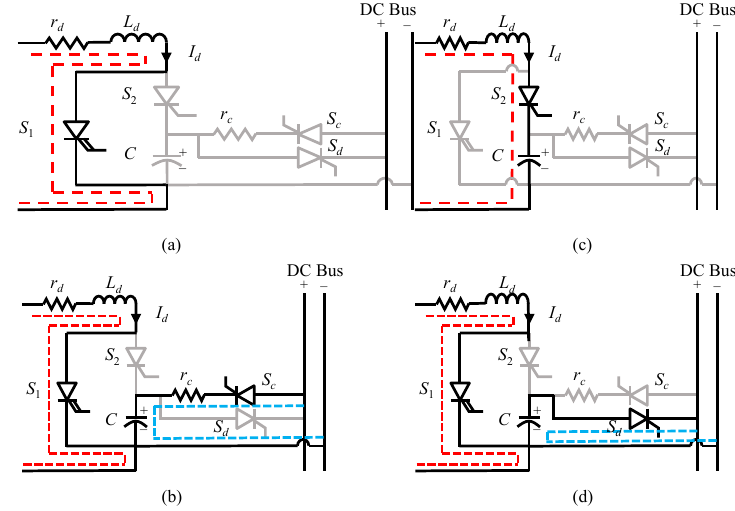
Figure 16. Performance of the proposed CBFCL: ( a ) under normal condition, ( b ) under normal condition considering charge of the capacitor bank, ( c ) under fault condition, and ( d ) after fault